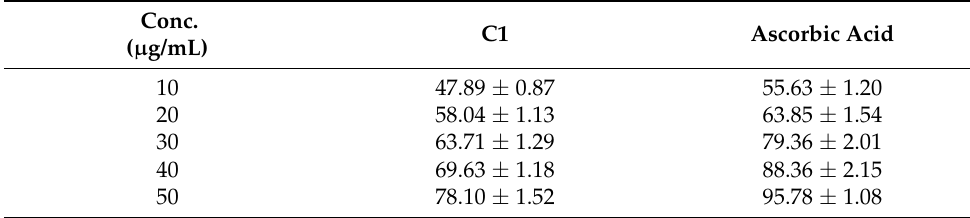
Table 9. Lipid peroxidation inhibition capacity activity of C1.